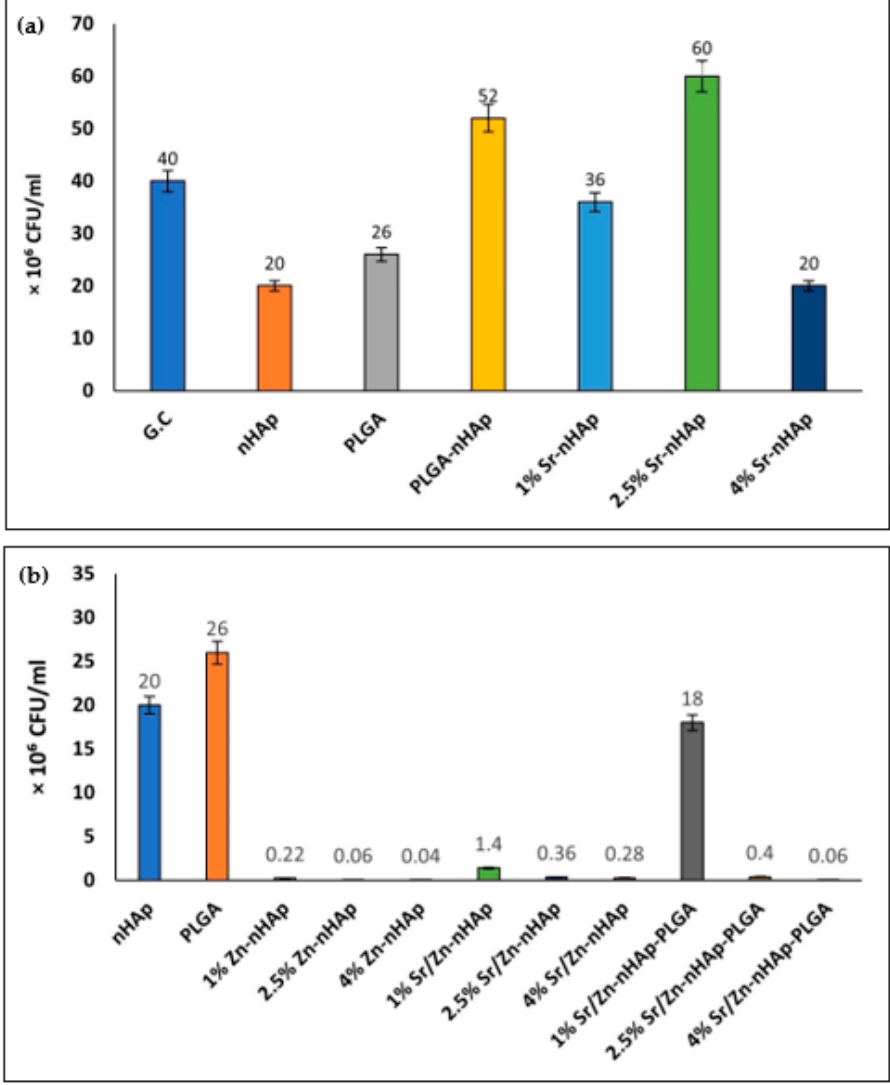
Figure 4. Bacterial CFU counts after 24 h of incubation with different scaffolds ( a ) G.C, nHAp, PLGA, PLGA ‐ nHAp, 1% Sr ‐ nHAp, 2.5% Sr ‐ nHAp, 4% Sr ‐ nHAp; ( b ) 1% Zn ‐ nHAp, 2.5% Zn ‐ nHAp, 4% Zn ‐ nHAp, 1% Sr/Zn ‐ nHAp, 2.5% Sr/Zn ‐ nHAp, 4% Sr/Zn ‐ nHAp, 1% Zn/Sr ‐ nHAp ‐ PLGA, 2.5% Zn/Sr ‐ nHAp ‐ PLGA and 4% Zn/Sr ‐ nHAp ‐ PLGA. The bacterial growth inhibition percentage of the different scaffolds was calculated from CFU numbers, using the nHAp scaffold as a control (Table 2). Zn 2+ ‐ containing scaf ‐